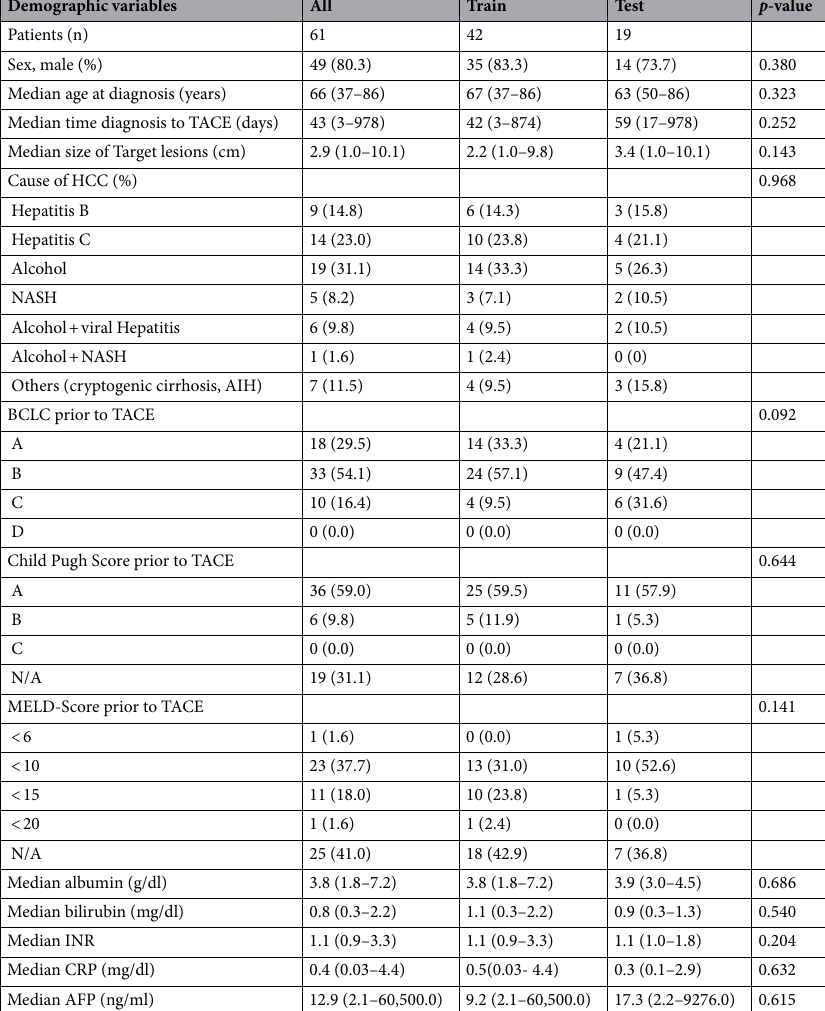
Table 1. Clinical and epidemiological characteristics. The train and test set were statistically analyzed using the Pearson Chi-Square test or two-sided t-test for ordinal or continuous